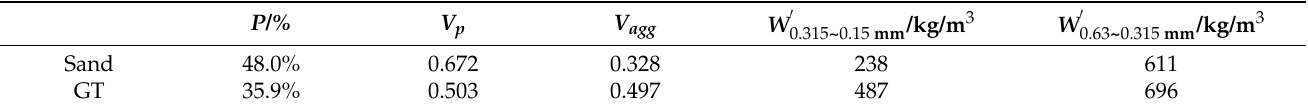
Table 8. Determination of final dosage of sand and